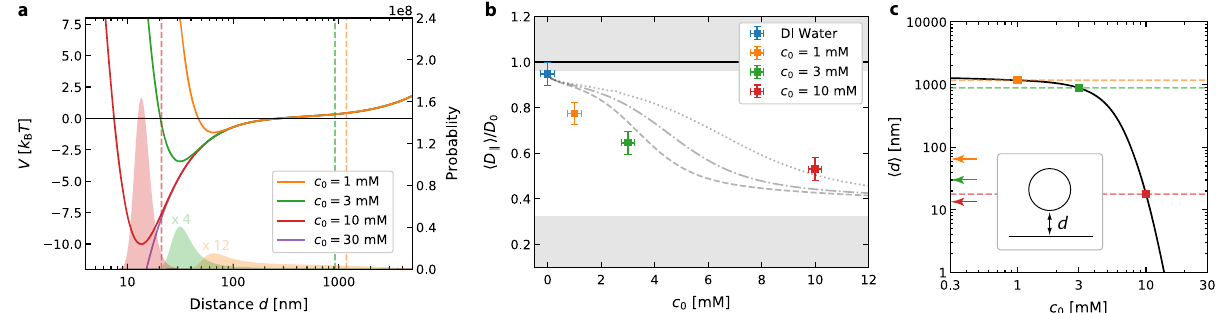
Fig. 2 DLVO potential and lateral diffusion analysis. a Plot of the DLVO potential, Eq. (1), between a 250 nm AuNP and a 50 nm Au fi lm on a glass surface as function of surface – surface distance d for different NaCl concentrations c 0 . The shaded curves display the calculated probability density for fi nding the particle at this distance at the different salt concentrations (see Supplementary Notes 4 for details). The vertical dashed lines correspond to the mean distance of the particle as calculated from the probability density for a 3 μ m liquid fi lm height. b The measured diffusion coef fi cient 〈 D ∥ 〉 / D 0 parallel to the Au fi lm with respect to the bulk diffusion coef fi cient D 0 as function of the NaCl concentration c 0 . Symbols correspond to the experimental values measured without additional laser heating of the gold fi lm. The lines re fl ect the theoretical prediction including a distance dependent diffusion coef fi cient for three different Hamaker constants (dotted: A H = 4 × 10 − 20 J, dash-dotted: 5 × 10 − 20 J, and dashed: 6 × 10 − 20 J) of gold according to a Boltzmann weighting (see main text). The error bars have been estimated from pipetting errors and errors from the MSD fi tting. c Relation between the mean distance 〈 d 〉 and the NaCl concentration c 0 . The symbols and the horizontal lines denote the calculated distances for measured concentrations. The arrows indicate the secondary minimum of the corresponding DLVO